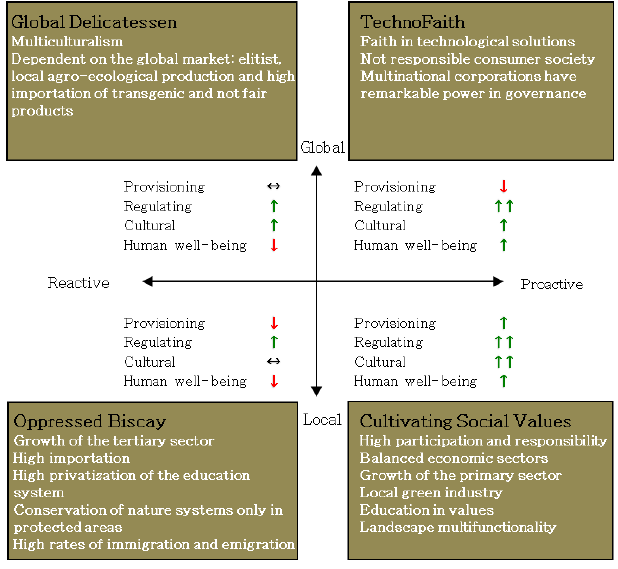
Fig. 4 . Summary of the evolution of ecosystem services and human well-being under each of the four scenarios. The vertical axis indicates two paths of global development: one in which the world becomes increasingly globalized and the other in which it becomes increasingly regionalized; and the horizontal axis indicates different approaches to ecosystem management, one in which actions are reactive and the other in which ecosystem management is proactive. Key aspects of each scenario are